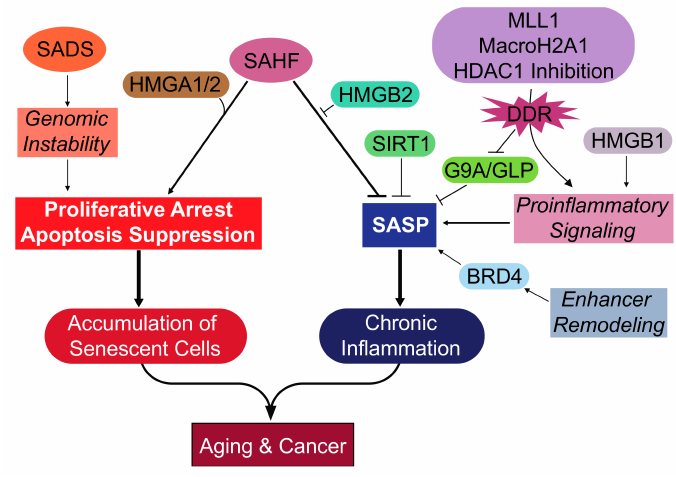
Figure 1. Overview of the epigenetic events and effectors during cellular senescence. Key epigenetic changes are development of the SADS and SAHF. The formation of SADS is an early epigenetic change that may aid in the growth arrest by promoting genomic instability. The SAHF collaborates with other epigenetic effectors and has several functions. The HMGA proteins structurally support the SAHF and aid in the repression of proliferation-promoting genes, resulting in the proliferative arrest. The HMGB2 protein prevents the incorporation of SASP gene loci into the transcriptionally repressive SAHF, thereby promoting the SASP. Transcriptionally repressive marks to SASP gene loci can be made by SIRT1 and G9a/GLP. The expression of the SASP is promoted by proinflammatory signaling mediated by MLL1, macroH2A1, HDAC inhibition, and HMGB1. Senescent cells also undergo remodeling in the enhancer landscape that promotes the expression of the SASP, which is mediated by BRD4. These epigenetic mechanisms support the proliferative arrest of senescent cells, which accumulate and impair tissue function, leading to aging. Another long-term deleterious effect of senescent cells is the SASP that activates chronic inflammation and promotes both aging and cancer. SAHF: Senescence-associated heterochromatic foci; SADS: Senescence-associated distention of satellites; SASP: